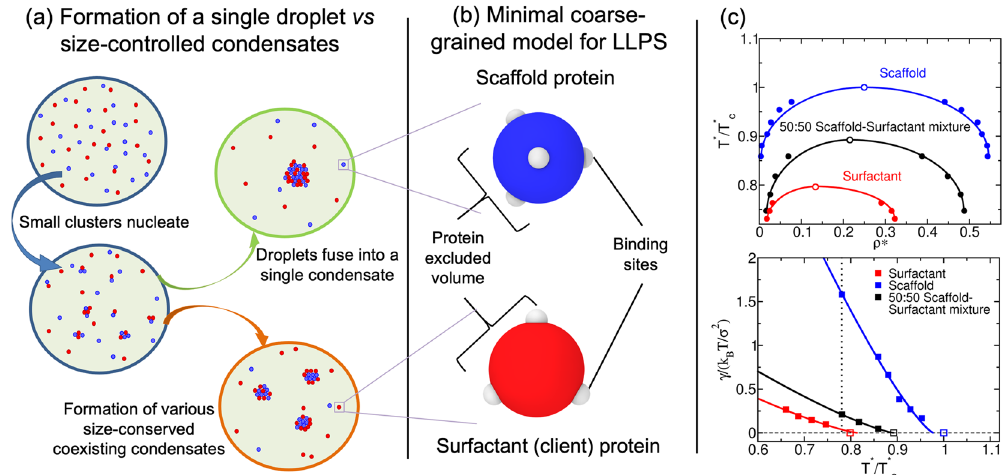
Figure 1. ( a ) Schematic representation of single-droplet formation versus size-conserved protein condensation. Scaffold proteins are depicted as blue spheres, while surfactant clients are shown as red spheres. ( b ) Minimal coarse-grained model for protein LLPS: Blue and red spheres represent the excluded volume of scaffold and surfactant (client) proteins respectively, while gray patches represent the binding sites of the proteins. Two different proteins are modeled: scaffold proteins, with 4 promiscuous binding sites in a tetrahedral arrangement, and surfactant proteins, with 3 binding sites in a planar equidistant arrangement that can only bind to scaffold binding sites (except where otherwise stated). Details on the model parameters are provided in the “Methods” section. ( c ) Top: Phase diagram in the temperature–density plane for a scaffold protein system (blue), a 50:50 scaffold–surfactant mixture (black) and for a hypothetical surfactant system in which client proteins can self-interact (red). The same self-interacting potential employed for scaffold proteins (blue) is also applied for surfactant proteins that can hypothetically self-interact (red). This system serves to further illustrate the effect of multivalency in LLPS. Filled circles indicate the estimated coexisting densities from Direct Coexistence simulations 68–71 , and empty ones depict the critical points calculated via the law of rectilinear diameters and critical exponents 72 (see Supporting Information for details on these calculations). Bottom: Surface tension ( γ ) dependence on temperature for the scaffold system (blue), the 50:50 scaffold–surfactant mixture (black), and the hypothetical system in which surfactant proteins can self interact (red). Filled squares represent direct estimations of γ , continuous curves depict fits to our data of the following form: γ ∝ ( T ∗ − T ∗ c ) 1.26 , and empty squares show the critical temperature of each system evaluated through the law of rectilinear diameters and critical exponents 72 . The vertical dashed line indicates the temperature at which the remainder of our study is performed. Note that temperature (in reduced units, T ∗ ) is renormalized by the critical temperature T ∗ c (also in reduced units) of the scaffold protein system ( T ∗ c = 0.12